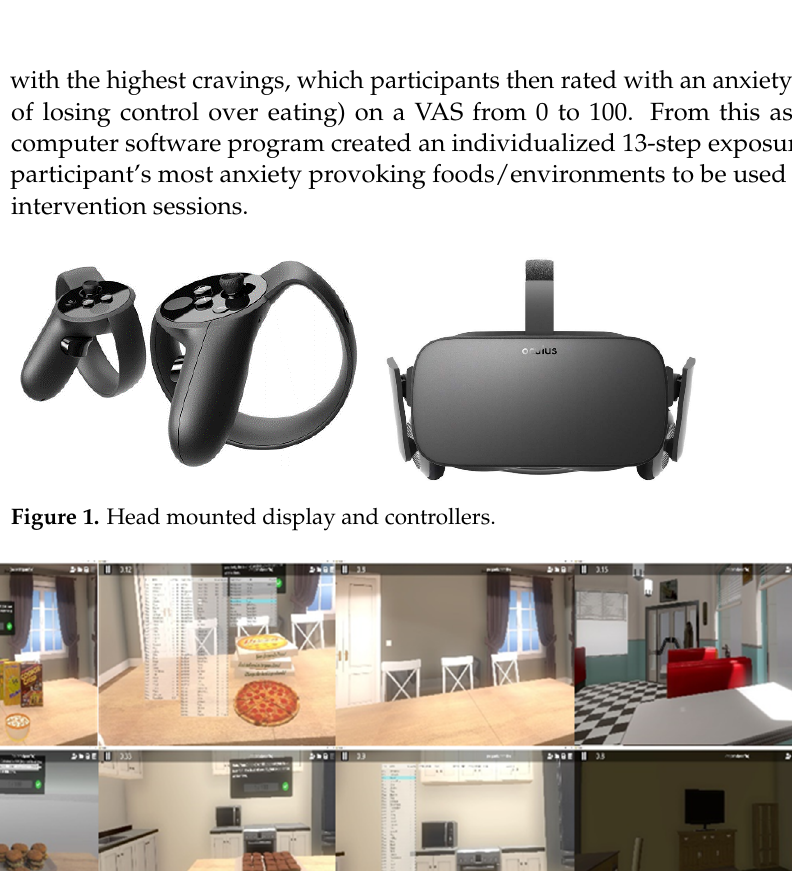
Figure 1. Head mounted display and controllers.